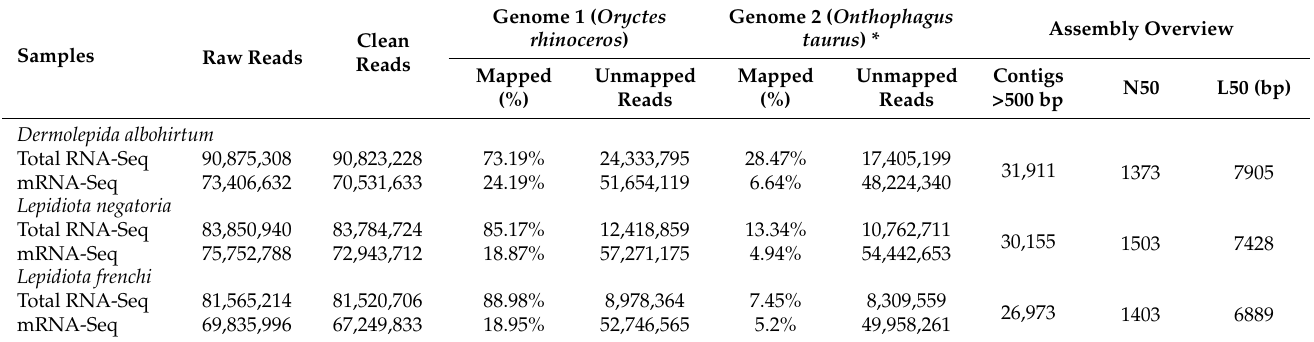
Table 2. Summary statistics of RNA-Seq libraries, mapping to proxy genome references and the de novo